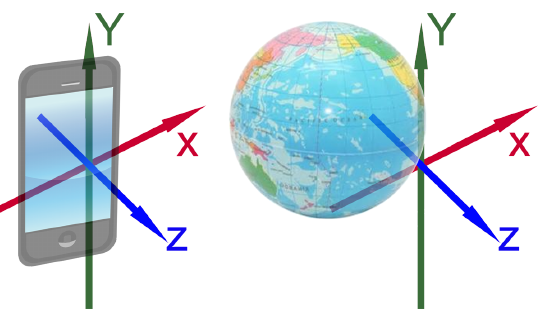
Figure 2. The device coordinate system and the world’s coordinate